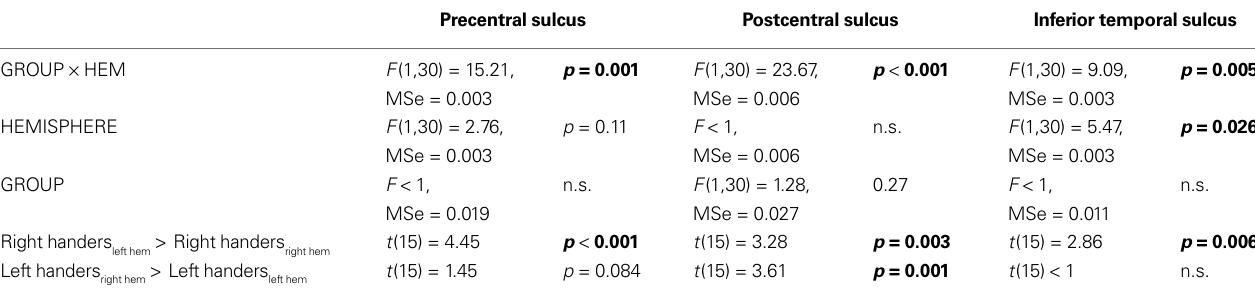
Table 4 | Results in regions of interest taken from the whole brain analysis ( Figure 1; Table 2 ). The whole brain analysis revealed three pairs of cortical regions that were sensitive to the overall MAN > NONMAN contrast (i.e. across groups, Figure 1 ): bilateral precentral sulcus, bilateral central sulcus, and bilateral inferior temporal sulcus. Results from these regions were analysed in an ANOVA with factors HEMISPHERE (left, right) and GROUP (left-handers, right-handers). In all regions there was a signifi cant GROUP × HEMISPHERE interaction. To subsequently test the direction of this effect, within group > Right handers > Left handers hemisphere differences were tested (i.e. Right handers and Left handers ). t -tests were one-sided. left hem right hem right hem left hem Differences signifi cant at the p < 0.05 level are indicated in bold